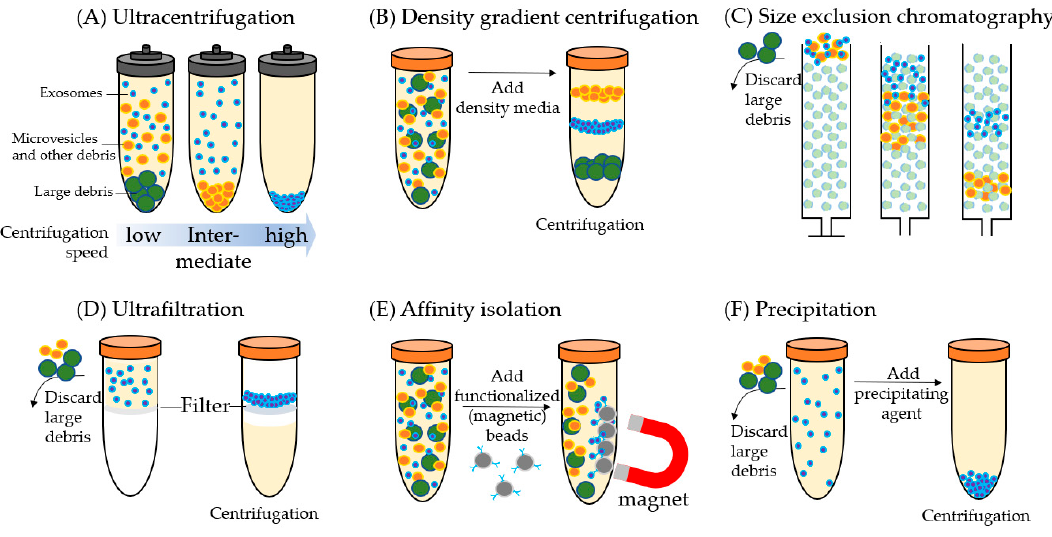
Figure 1. The common methods for isolating exosomes. Blue particles: exosomes; orange particles: microvesicles and other debris; green particles: large debris. ( A ) Ultracentrifugation separation is based on size, and large-size debris and microvesicles are collected earlier at the bottom of the tube and at lower g forces than the smaller exosomes. ( B ) Density gradient centrifugation separation is based on density. Exosomes will travel to their equilibrium density in the centrifugation media. ( C ) Size exclusion chromatography uses a porous matrix (dotted circles) that separates based on size. Soluble components and particles smaller than pore size enter the porous matrix temporarily hence elute later than the particles larger than the pore size. ( D ) In ultrafiltration, soluble proteins and particles smaller than the molecular weight cutoff of the filter (e.g., 105 kDa) are centrifugated through the filter, and the exosomes are collected in the fluid retained by the filter. ( E ) In affinity isolation, exosomes are captured based on their immunophenotype or specific ligands on the surface. Exosomes are often captured using a monoclonal antibody or exosome-specific ligand conjugated to magnetic nanoparticles and captured by magnets. ( F ) In precipitation, the addition of a precipitating agent induces clumping of exosomes and the clumps can be collected by centrifugation. While performing method ( A , C , D , F ) large debris needs to be separated (e.g., by low-speed centrifugation) and discarded before exosome isolation.